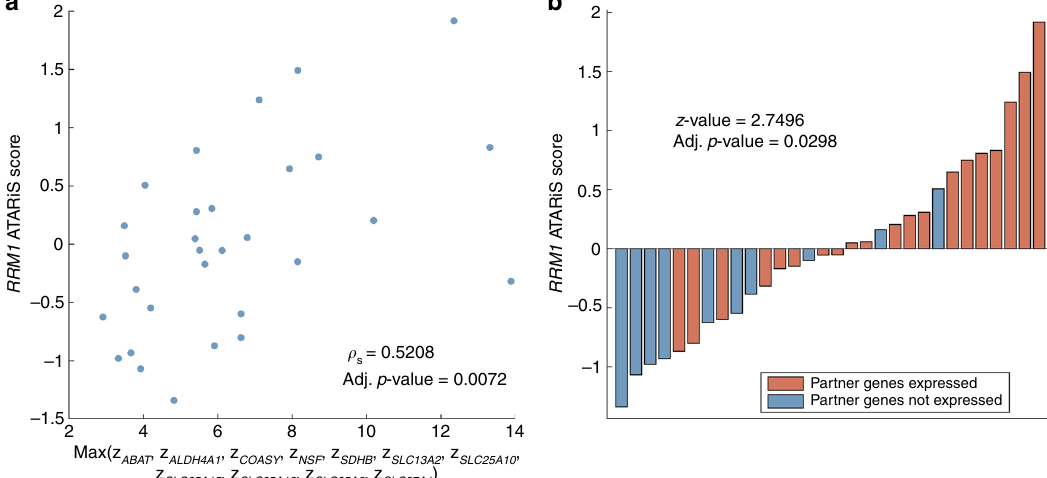
Fig. 4 Sensitivity to RRM1 silencing in the top 30 Achilles cell lines regarding quality and expression of partner genes in gMCS 6 . a Spearman ’ s correlation analyzing the dependence of RRM1 ATARiS score on gene expression levels of partner genes in gMCS 6 . b Bar plot of RRM1 ATARiS score when partner genes are (or not) expressed in gMCS 6 . To decide whether a gene is expressed, we used the standard threshold provided by the Gene Expression